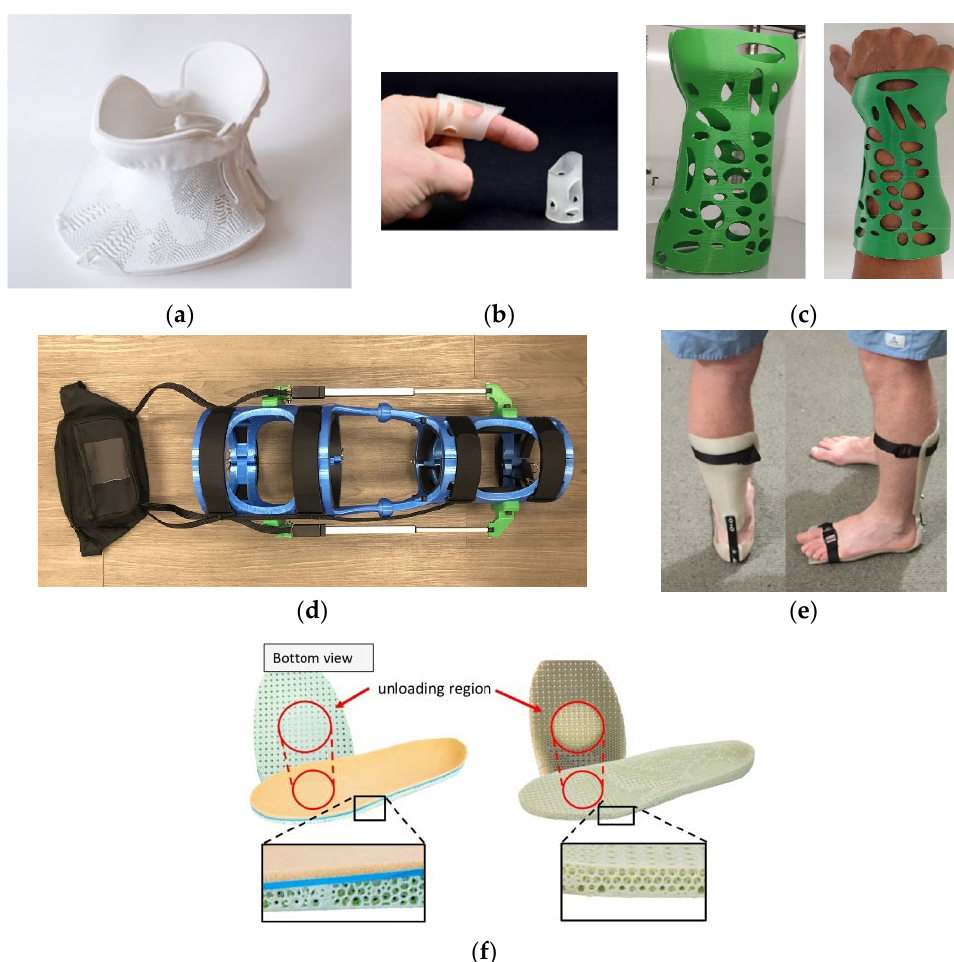
Figure 32. Orthosis devices for ( a ) neck [193], ( b ) finger [189], ( c ) hand [190], ( d ) knee [191], ( e ) ankle [194], and ( f ) foot [192].